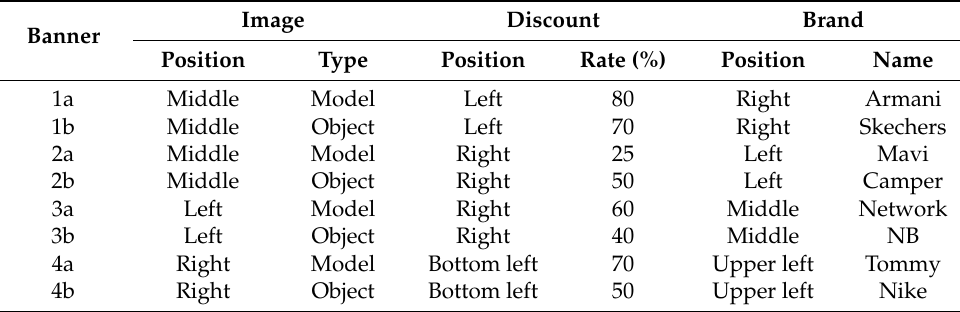
Table 1. Layouts and details of the eight banners selected for this study. Image Banner